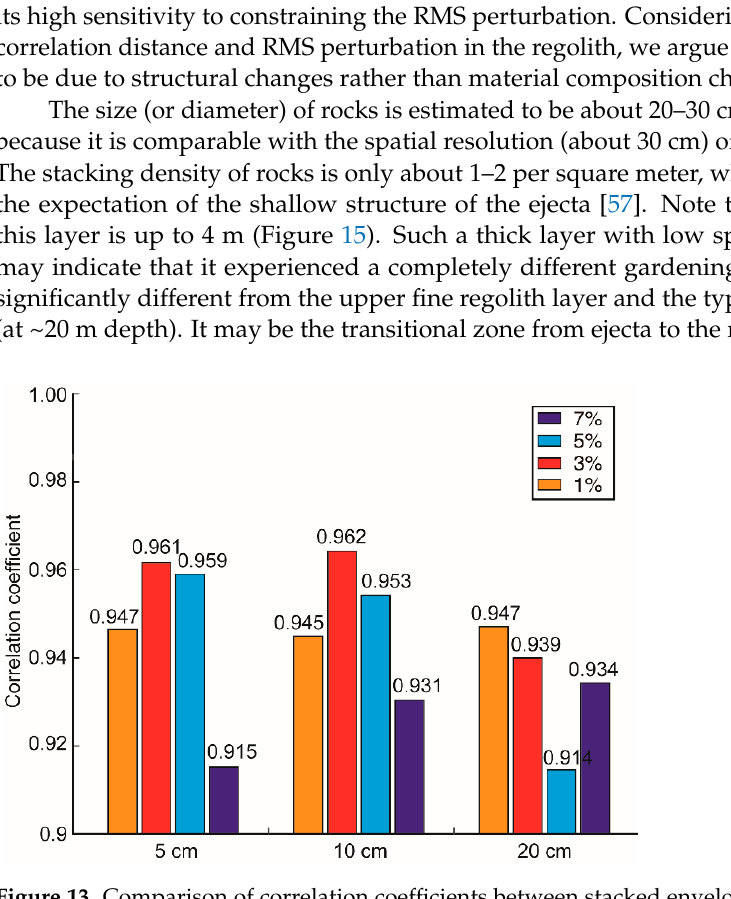
Table 2. Square errors between Yutu-2 LPR data and synthetic data.